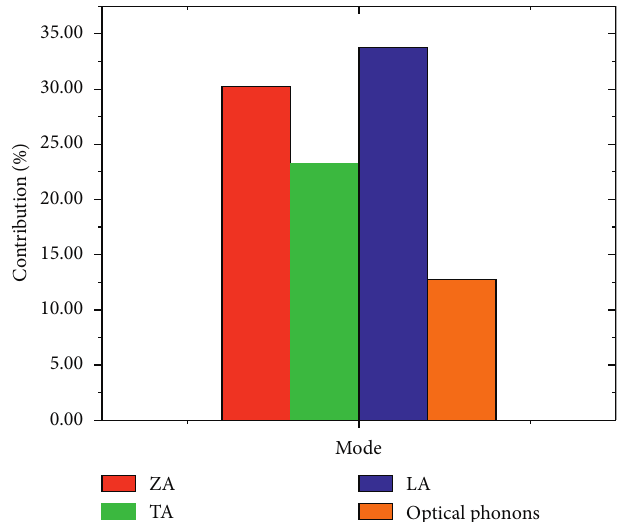
Figure 3: Contributions of phonon modes to total lattice thermal conductivity, where the red bars represent the ZA branches of acoustics, the green bars represent the TA branches of acoustics, the blue bars represent the LA branches of acoustics, and the orange bars represent the optical